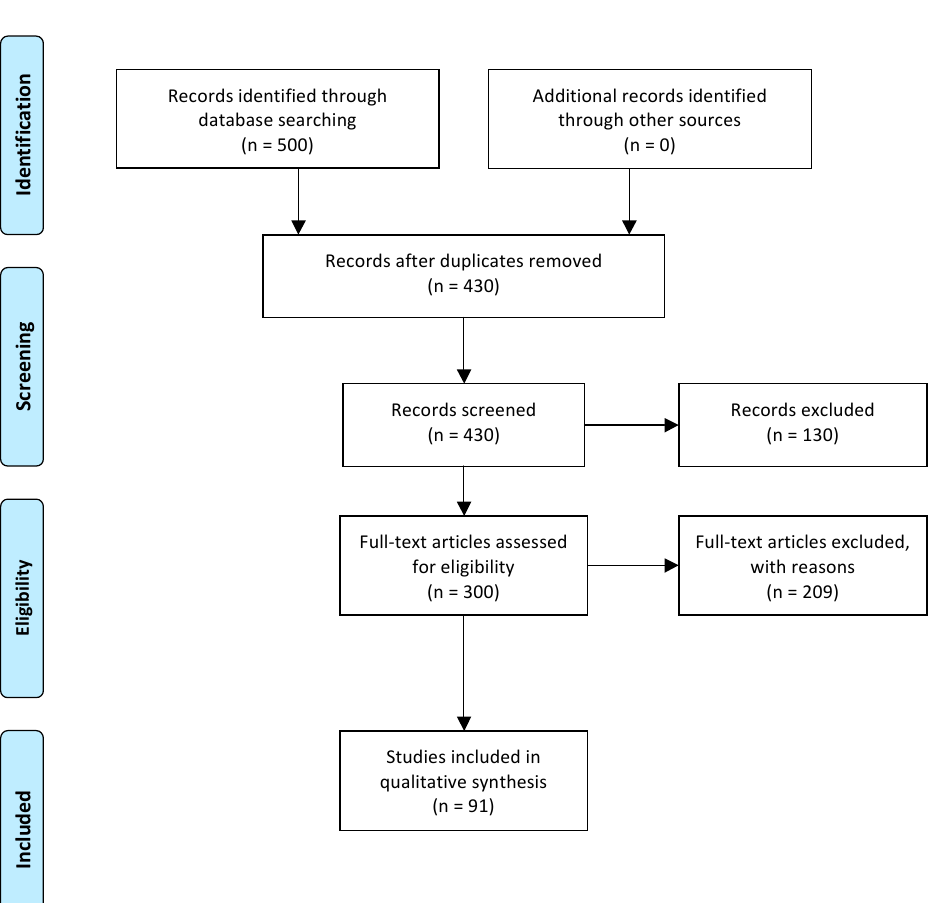
Figure 1. Flow diagram according to Prisma 2009 guidelines. A total of 500 records were identified for this study in three online databases (Pubmed, Scopus, Web of Science) using this search expression: “Redox AND Balance AND Physical activity OR Exercise AND Age AND Signal transduction”. After removing duplicates, we found 430 articles, and after first screening, 130 were excluded. 300 full-text articles were assessed for eligibility, and 209 were excluded because results were partially redundant. Finally, 91 studies were included in qualitative synthesis. We did not use any date limit.